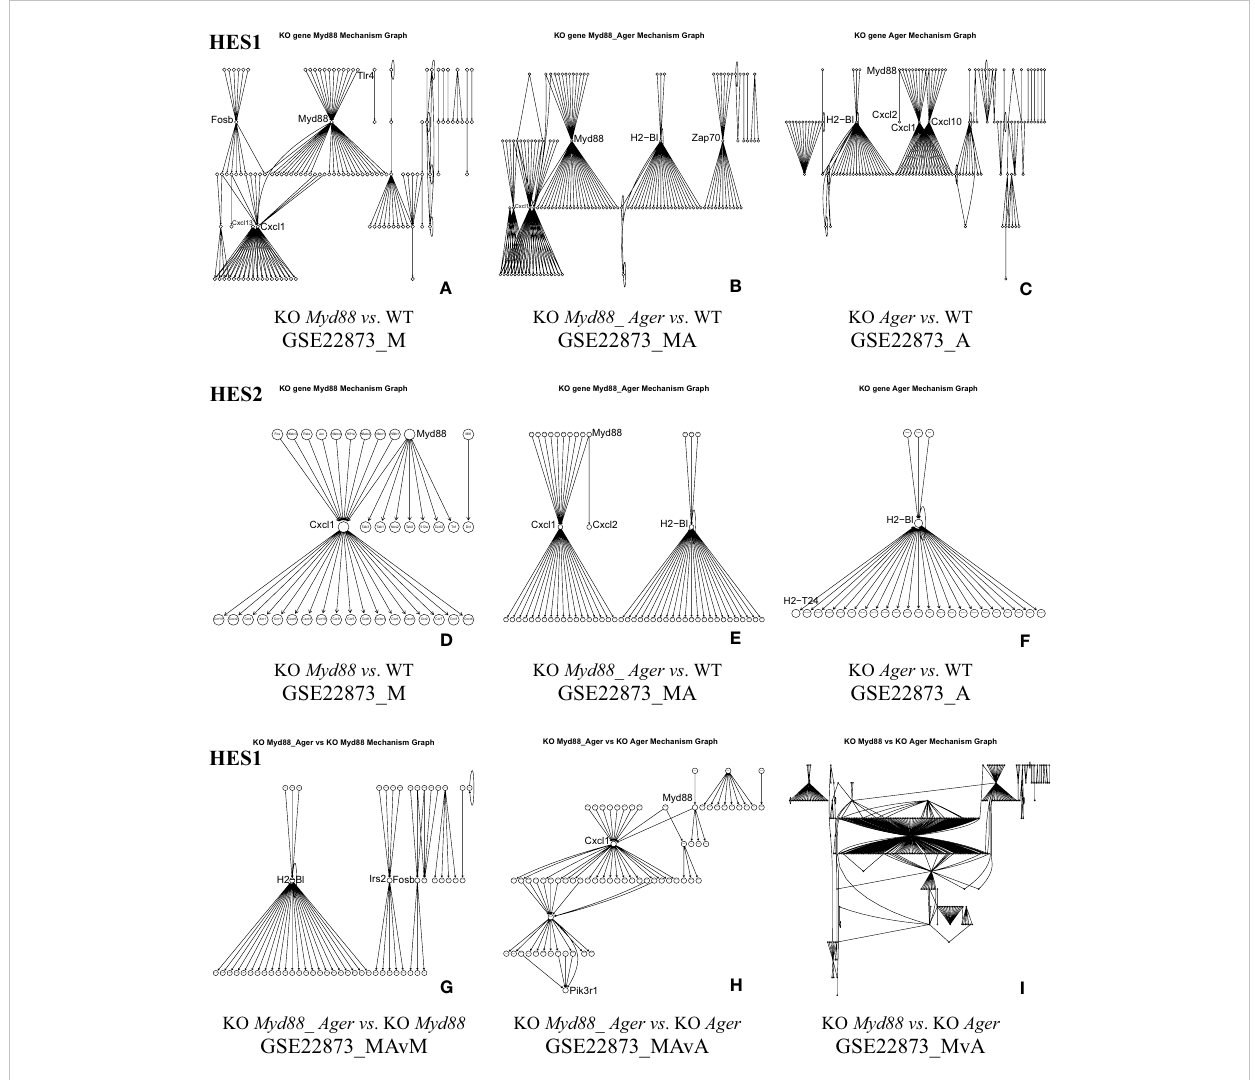
FIGURE 5 The KO gene-associated subnetworks comprised of DEGs statistically determined by HES1 and HES2. Landscapes are displayed since many node labels are unreadable by humans. Representative key nodes (e.g., Myd88, Cxcl1 and H2-Bl) are enlarged for clarity. (A) GSE22873_M, (B) GSE22873_MA, and (C) GSE22873_A at HES1; (D) GSE22873_M, (E) GSE22873_MA, and (F) GSE22873_A at HES2; (G) GSE22873_MAvM, (H) GSE22873_MAvA, and (I) GSE22873_MvA at